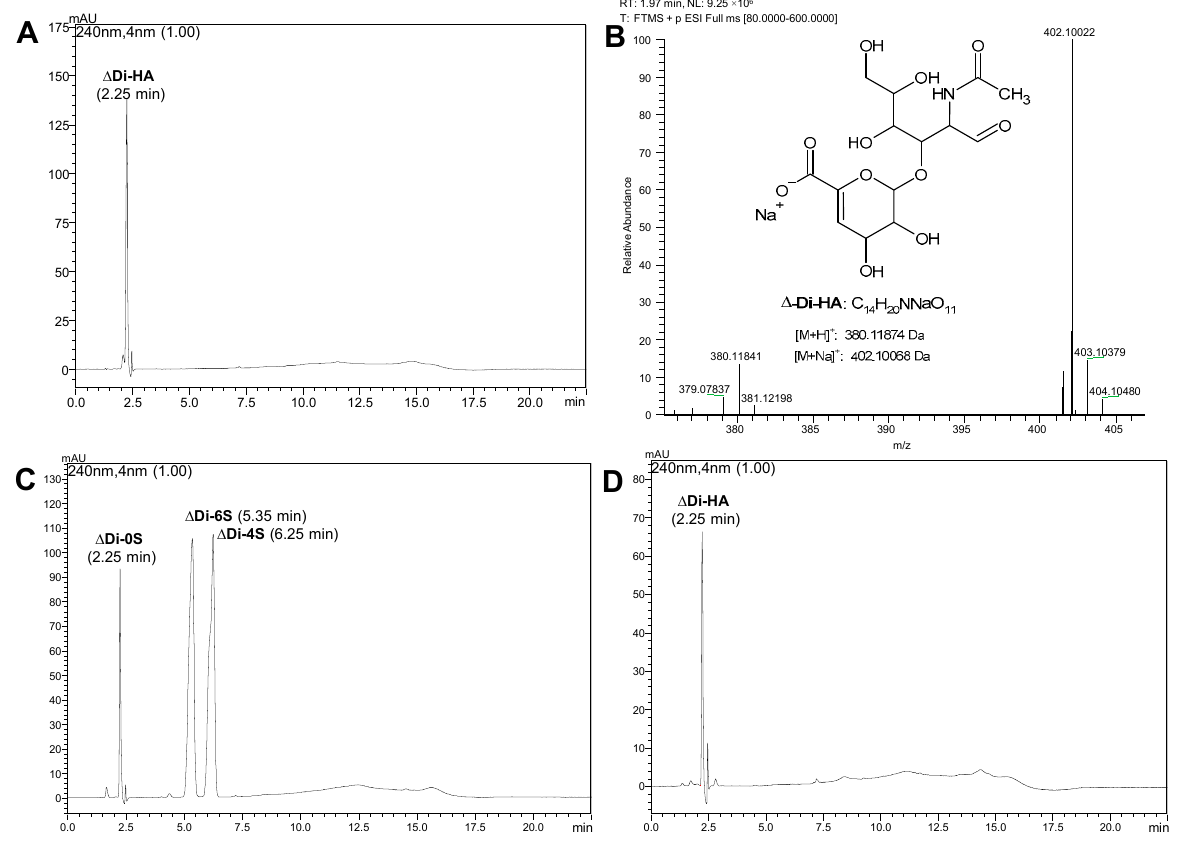
Figure 1 . HPLC-UV and high-resolution mass spectrometry (HRMS) analysis of GreenIuronic ® after enzymatic hydrolysis with chondroitinase AC. In ( A , B ) HPLC-UV chromatogram of GreenIuronic ® sample and its positive HRMS spectrum. In ( C , D ) HPLC-UV chromatograms of a mixture of chondroitin disaccharides standard ∆ Di-0S, ∆ Di-4S, and ∆ Di-6S and a solution of the disaccharide standard ∆ Di-HA of HA. Table 1. Quantification of HA. The % w/w of all HA forms normalized on standard curves generated using glucuronic acid standard (ranging from 0 to 2 mg/mL) analyzed at 340 nm by spectrophotometry (Infinite 200 Pro MPlex, Tecan). Data are expressed as means ± standard deviation (SD) (%) of five independent experiments performed in triplicates.